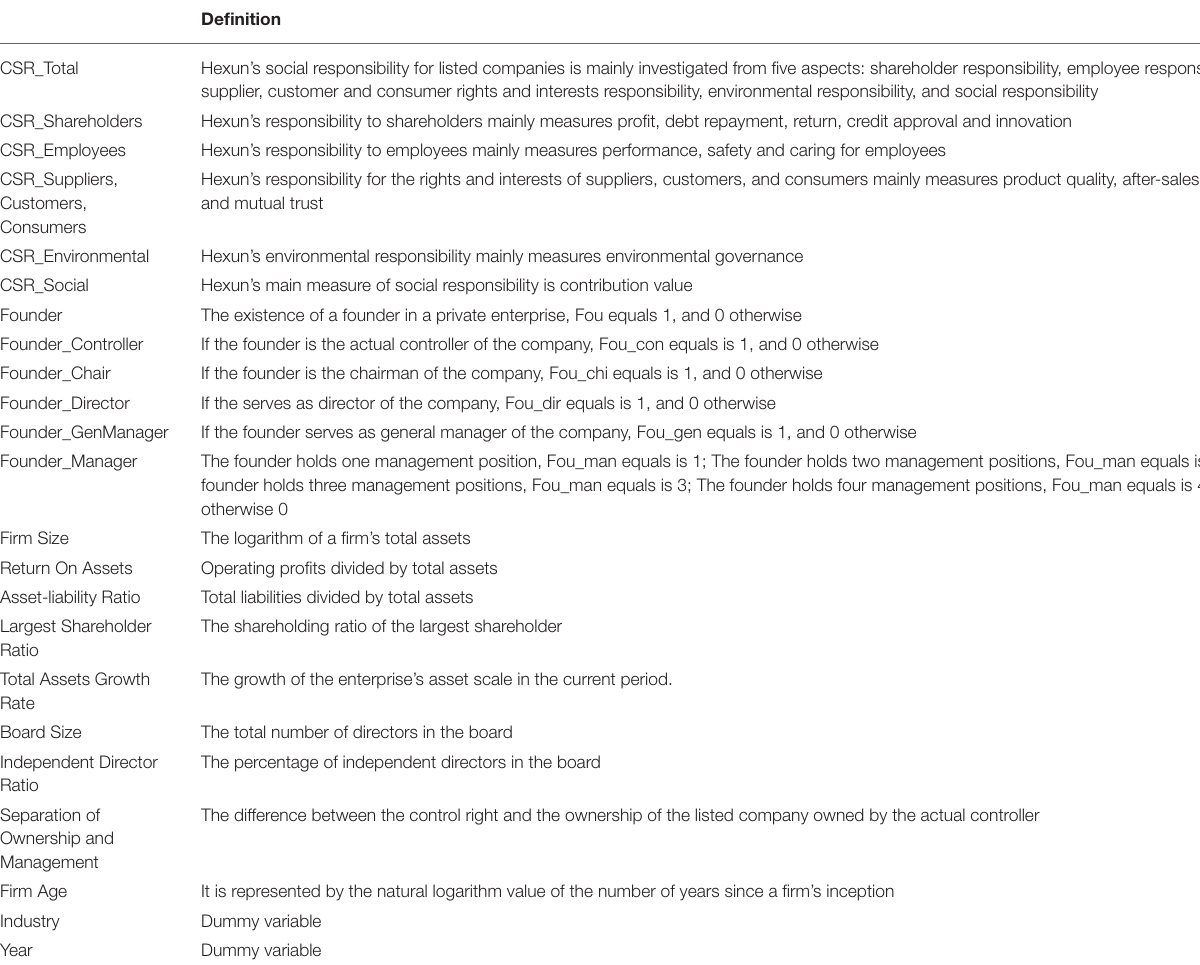
TABLE 2 | Variable